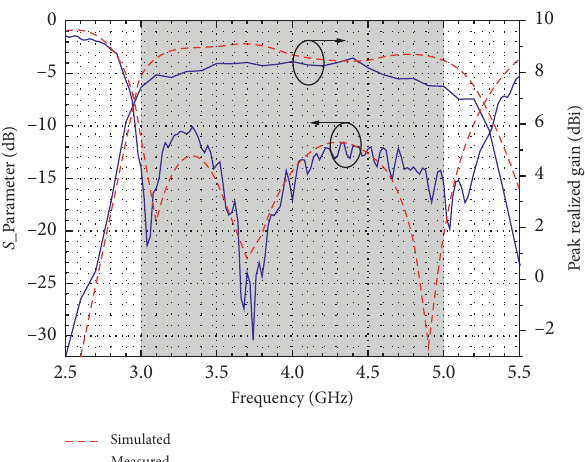
Figure 6: The simulated and measured reflection coefficients and peak realized gains of the proposed